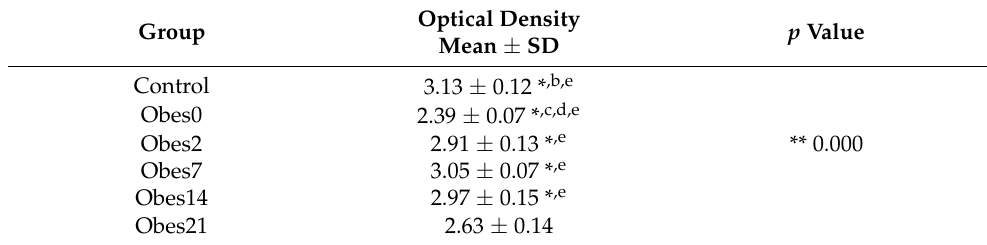
Table 1. SREBP-2 protein OD values.